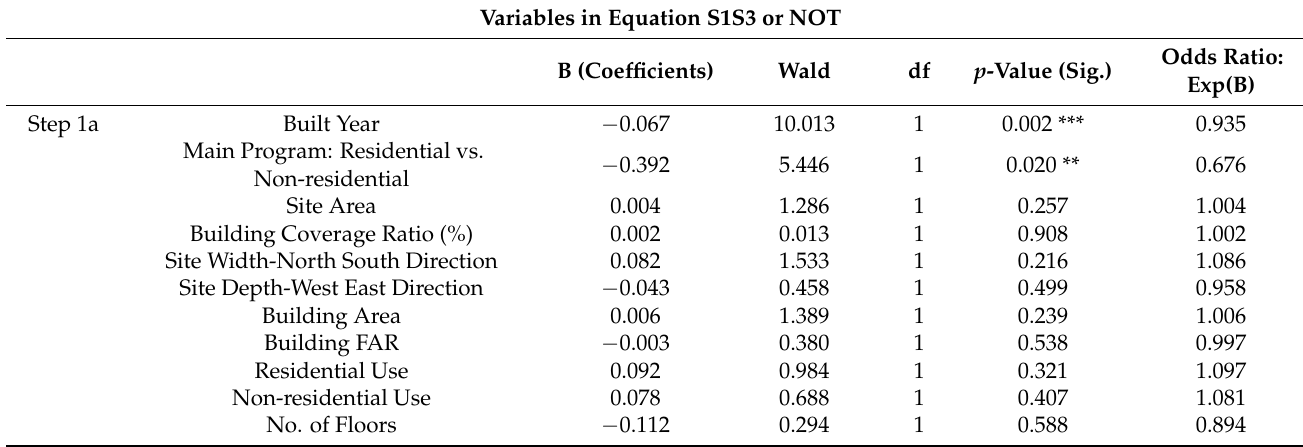
Table 4. Binary logistic regression analysis result: S1S3 or NOT.